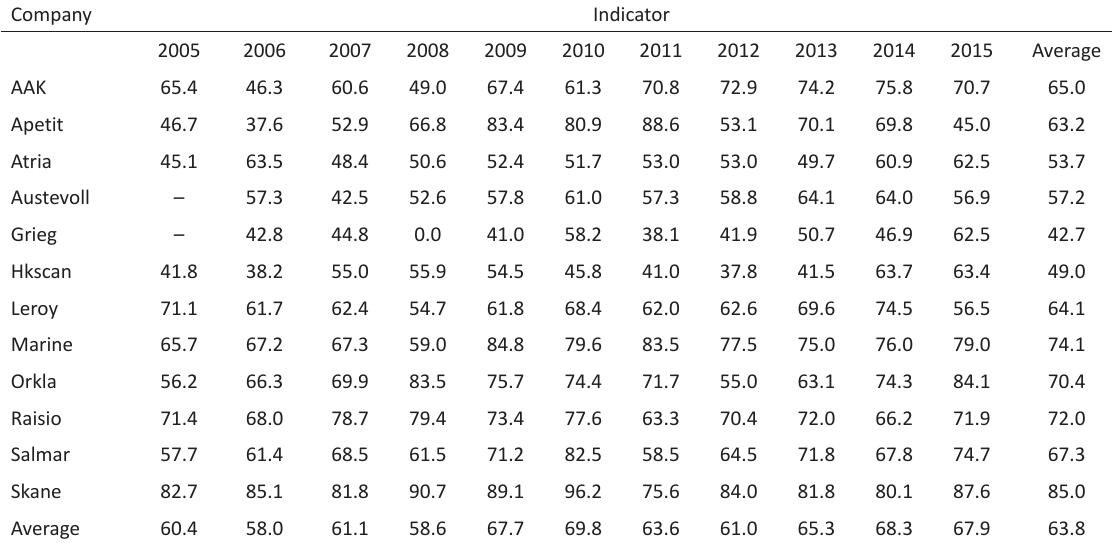
Table 3. The sub-indicator of current liabilities (A2) of food companies from Northern Europe Company